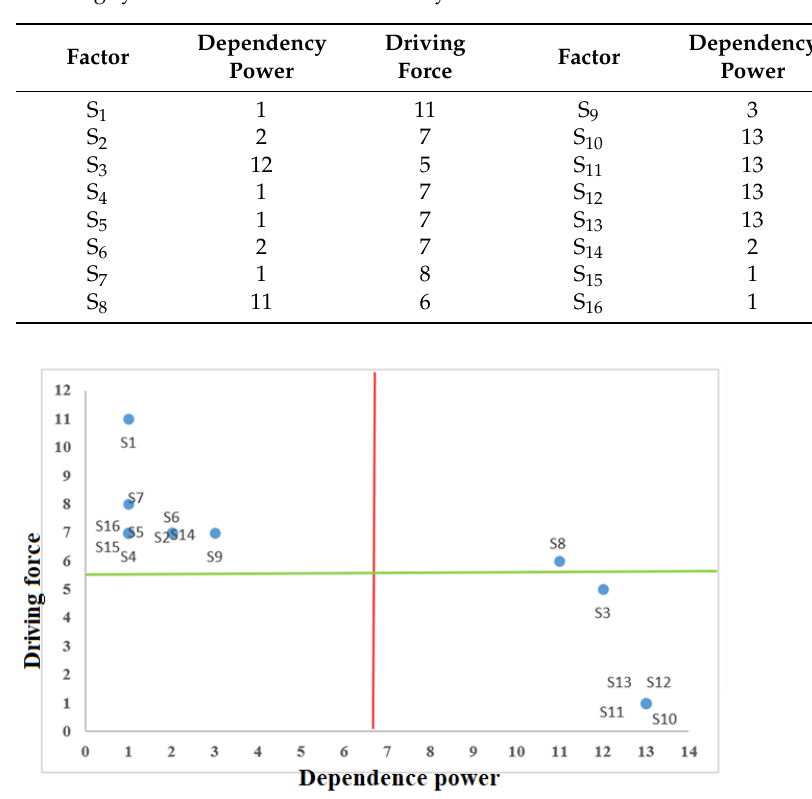
Table 7. Driving-force-dependency power of factors influencing the brittleness of lean–green manu- facturing systems in the context of Industry 4.0.